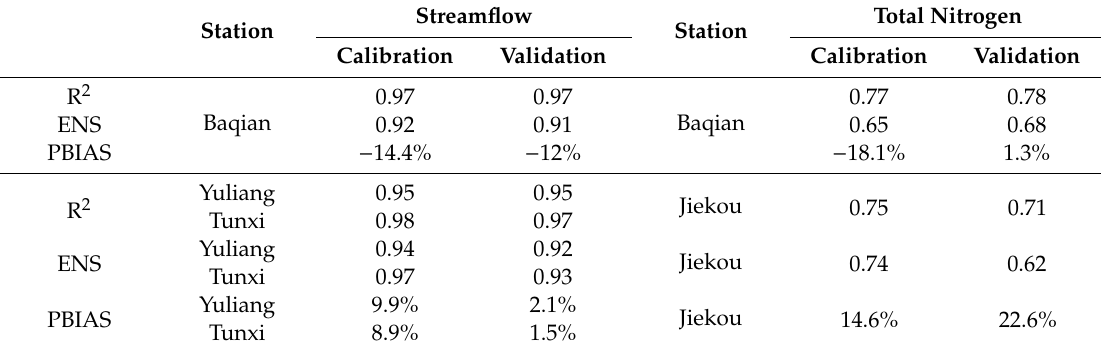
Table 3. Performance of the SWAT model in simulating streamflow and TN loads in the QLB. Station